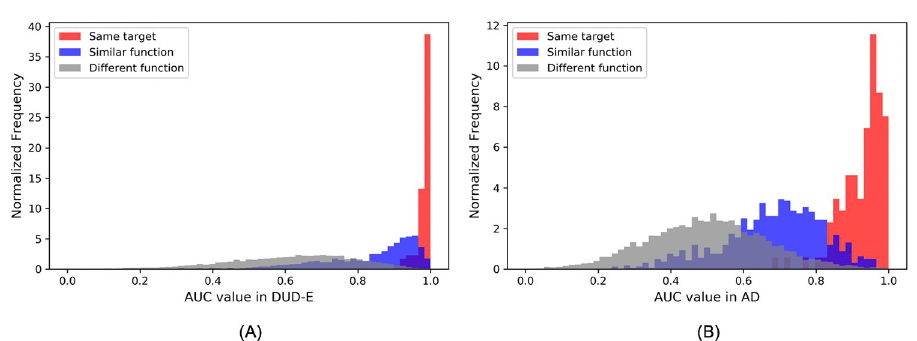
Fig 11. AUC distributions for the ligand-only CNN model (102 � 102 prediction) across three groups of targets. (A) Results for models tested using the DUD-E dataset; (B) Results for models tested using the AD dataset. The distributions are normalized such that the area under each distribution curve equals 1.